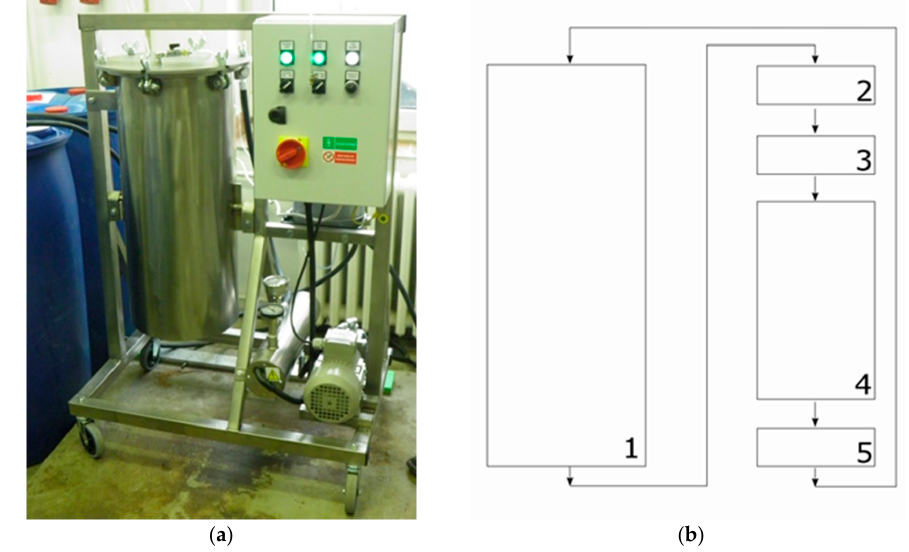
Figure 7. Percolation device: ( a ) Device for oil treatment; ( b ) scheme of rapeseed oil treatment (1—oil container, 2—pump, 3—heating unit, 4—sorbent column, 5—filter). Table 4. Parameters of original and treated rapeseed oil.